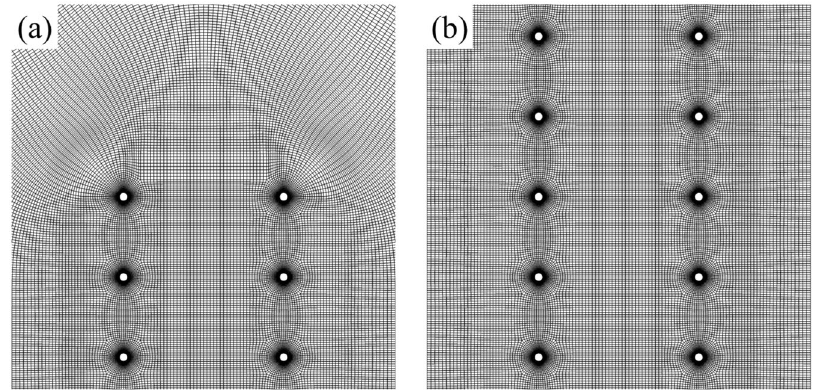
Figure 2. ( a ) A Portion of the grid near the leading edge of two bristled wings and ( b ) a portion of the grid near the middle of two bristled wings.